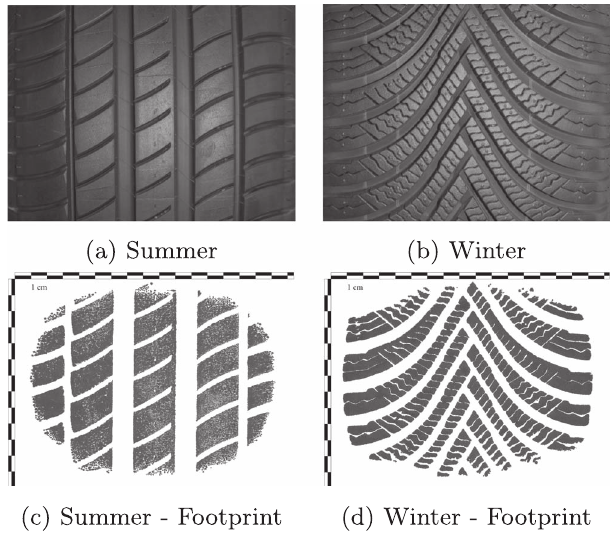
Figure 2. Selected tires for this study. Both tires have the same dimension 205/55R16. We made the footprints with a tire load of 3600